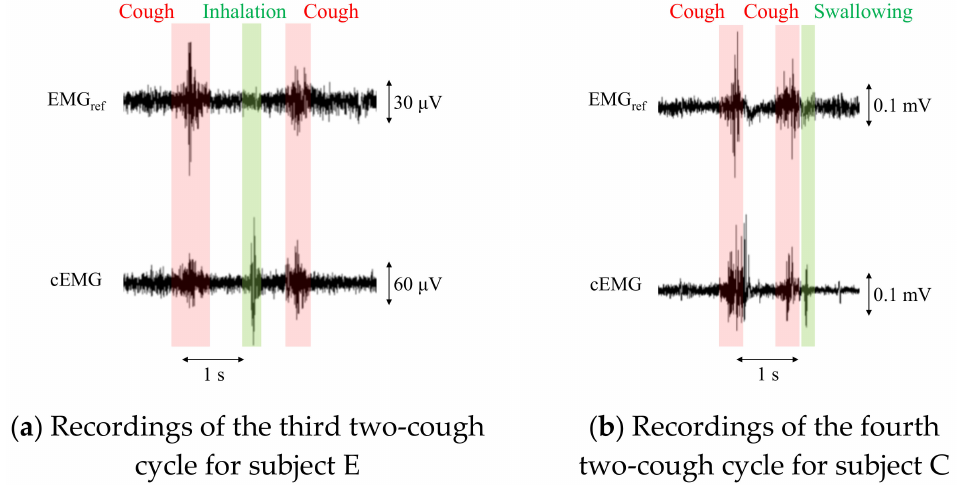
Figure 9. Recordings of EMG ref and cEMG including a two-cough cycle for subjects E and C. In the cEMG signals, firings considered to be associated with inhalation ( a ) and swallowing ( b ) were also confirmed by the two-cough